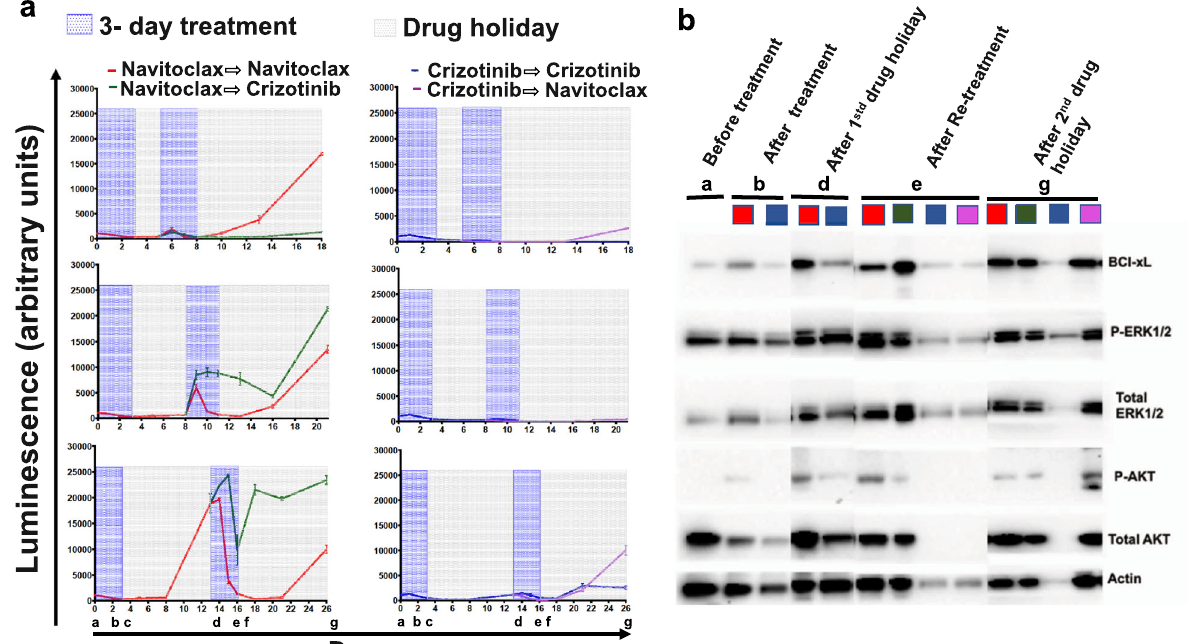
Fig. 3 Sequential regimens result in different patterns of resistance. a Growth curves associated with sequential treatment regimens and schedules. Cells received a 3-day treatment followed by 2 days (top), 5 days (middle), or 10 days (lower) of recovery in cycle 1, followed by 3- day treatment and 10-day recovery in cycle 2. Left Panel: navitoclax given as cycle 1 treatment. Right panel: crizotinib given as cycle 1 treatment. b Quanti fi cation by Western blot of protein levels involved in targeted pathways at different times in the treatment cycle. Letters correspond to the time points on the plots in a . The colors identifying the different samples at each time point corresponding to the color of the curves in a